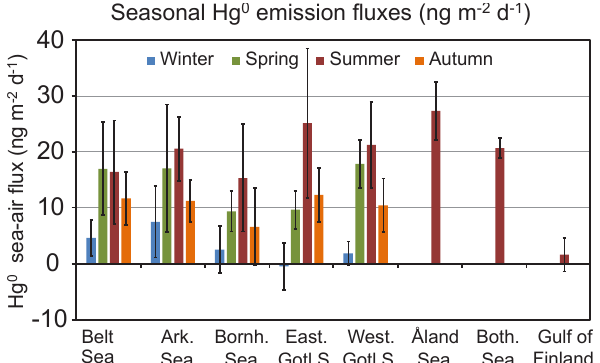
Figure 7. The average seasonal mercury emission of selected Baltic Sea areas determined based on the data from this and a previous study (Kuss and Schneider, 2007). Standard deviation is